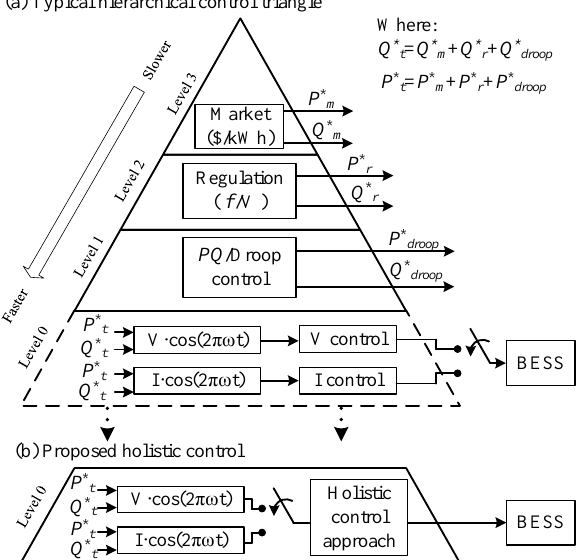
Figure 1. Control scheme: ( a ) hierarchical control [6,7] and ( b ) holistic